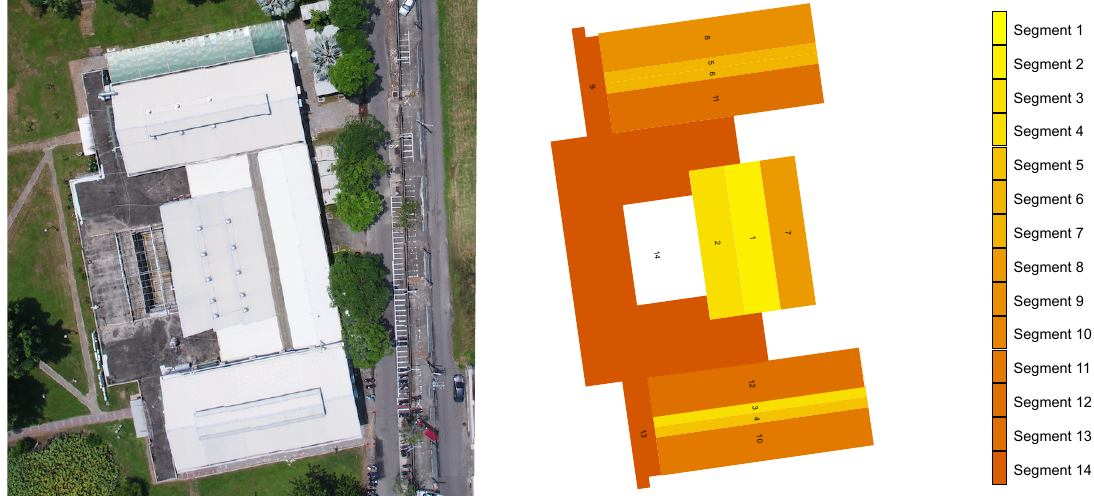
Figure 7. Plan View of Idea Factory Roof ( left ), three-dimensional (3D) model of the Roof showing roof segments for solar analysis ( right